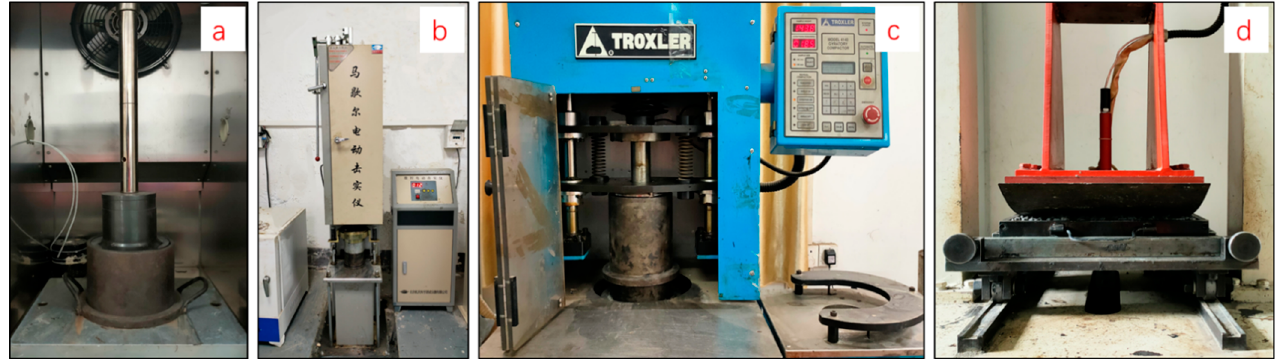
Figure 2. Test setup for aggregate crushing resistance analysis (( a ): dynamic ACVT; ( b ): Marshall hammer compaction; ( c ): gyratory compaction; ( d ): steel roller compaction). hammer compaction; ( c ): gyratory compaction; ( d ): steel roller